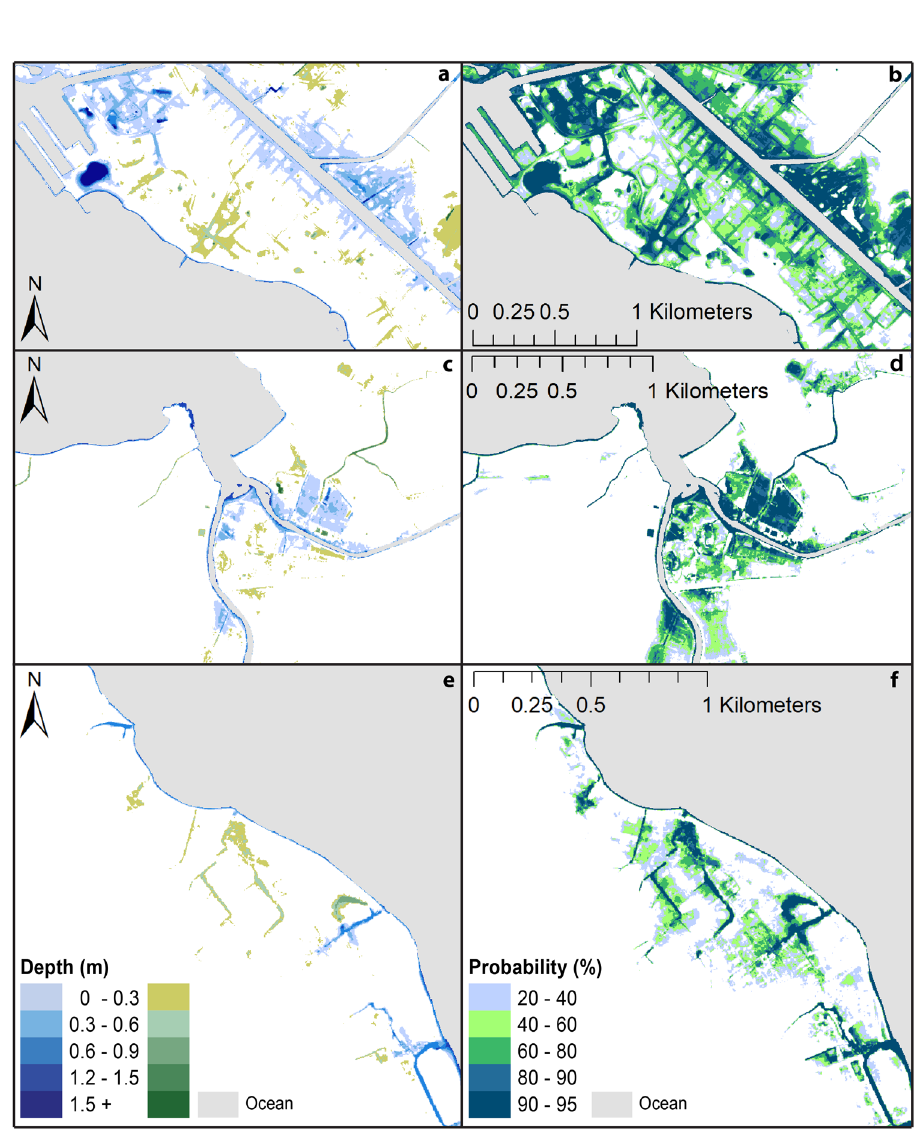
Figure 4. Maps depicting flooding under the Intermediate scenario by 2100 of Sweet et al. 23 for the Honolulu tide gauge (1.19 m) using the ORS method. ( a , c , e ) Show the range of flood-depths with at least 80% probability of occurrence for Waikīkī, Hale ʻ iwa and Hau ʻ ula, respectively (blues—surficially connected; greens— topographically isolated). ( b , d , f ) Show probability ranges for lands experiencing any amount of flooding in Waikīkī, Hale ʻ iwa and Hau ʻ ula, respectively (distinction between surficially connected and topographically isolated not identified). (Maps generated with ArcGIS Desktop 10.8.2; http:// www. esri.